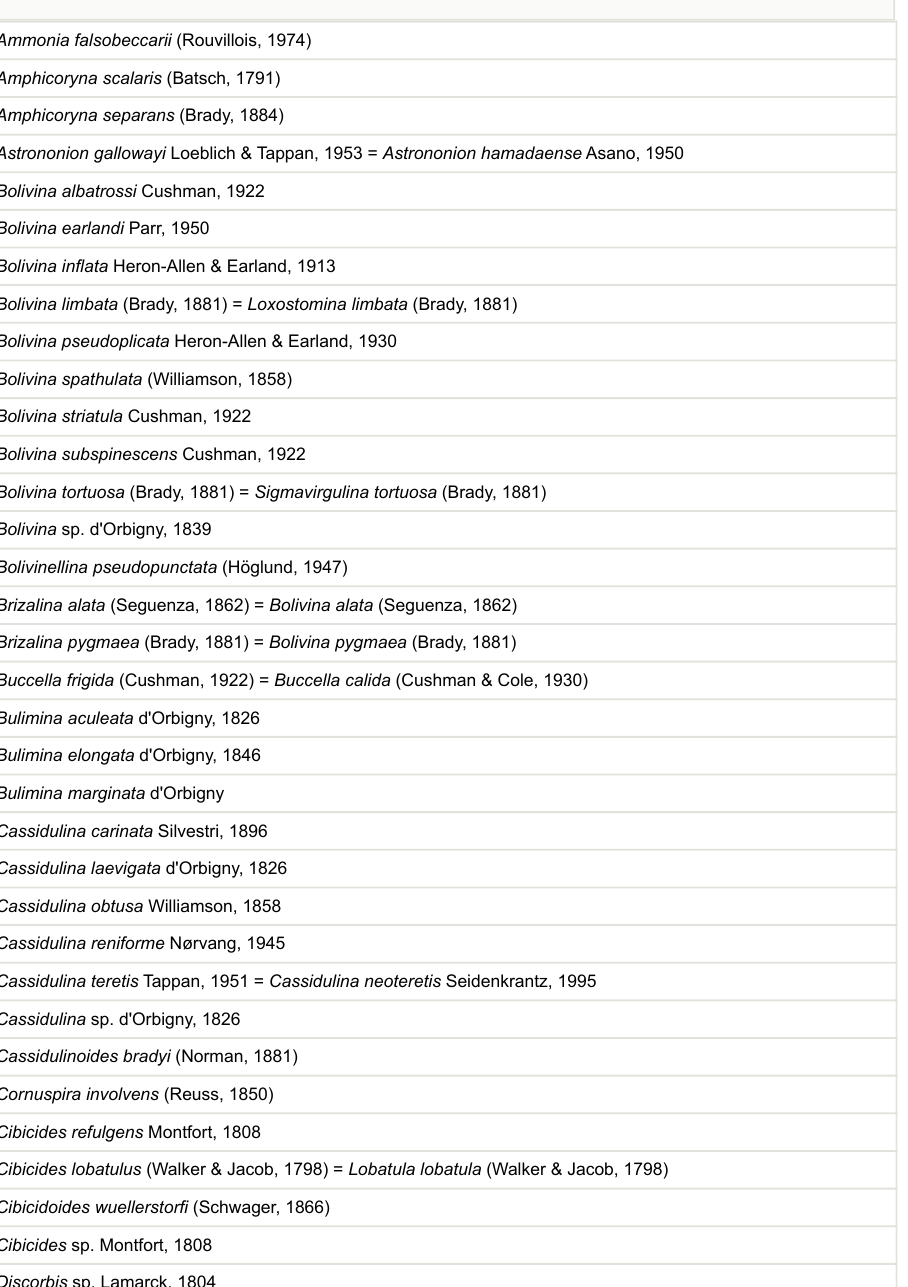
List of benthic foraminiferal taxa in station AMK-5656 from north-western Scotland shelf in North